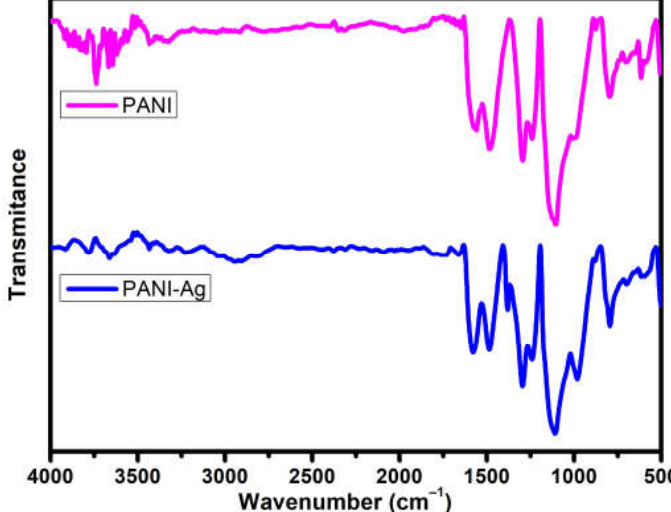
Figure 3. FTIR spectra of PANI and the PANI-Ag composite. Table 1. FTIR spectral assignment for PANI and the PANI-Ag